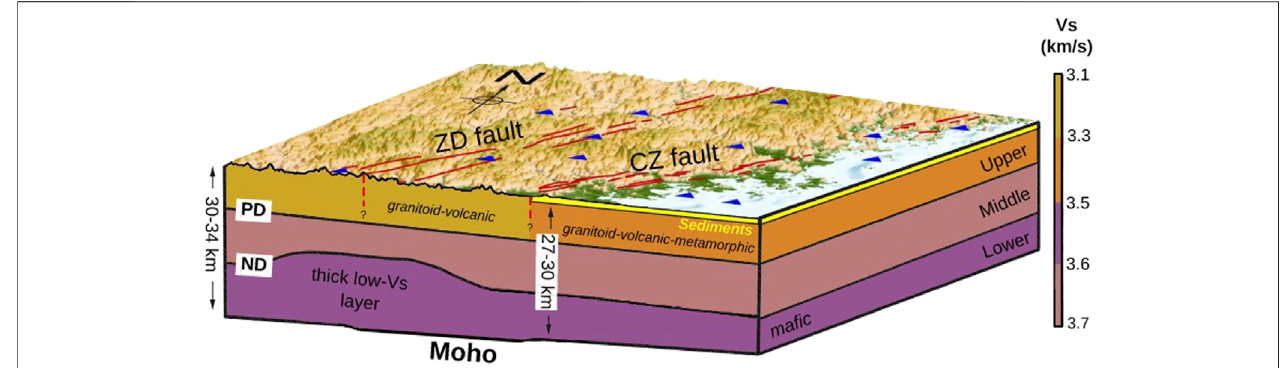
FIGURE 8 | A 3-D interpretation diagram of the crustal features in the Fujian province resulting from our receiver function analysis.